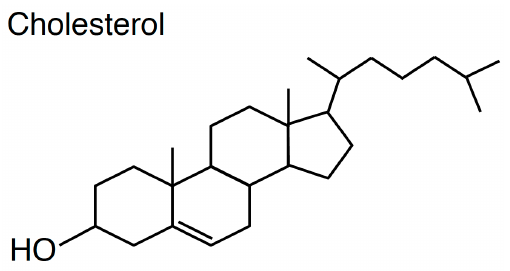
Figure 1. Molecular structure of cholesterol.